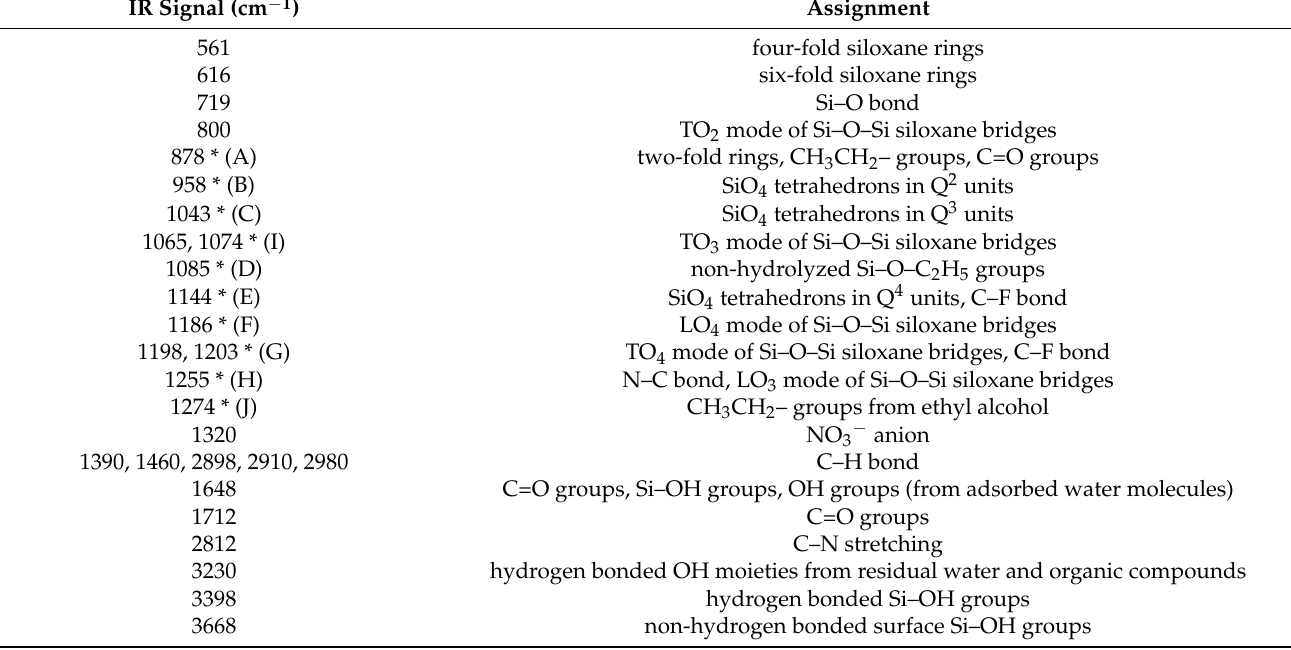
Table 1. The assignment of individual IR bands in the 500 cm − 1 –4000 cm − 1 frequency region recorded during all steps of sol-gel transformation. Bands marked with an asterisk (assigned as A–J in the text) were revealed via deconvolution. IR Signal (cm − 1